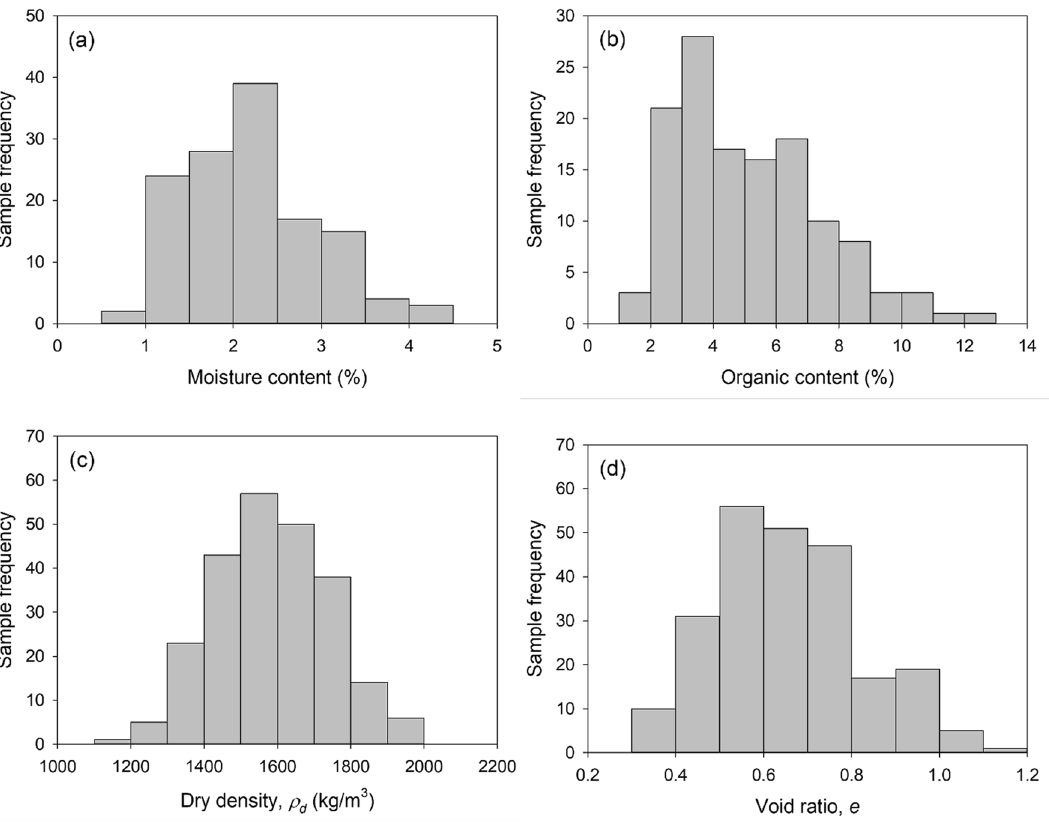
Figure 3. Physical properties of nest samples: ( a ) moisture content, ( b ) organic content, ( c ) dry density, and ( d ) void